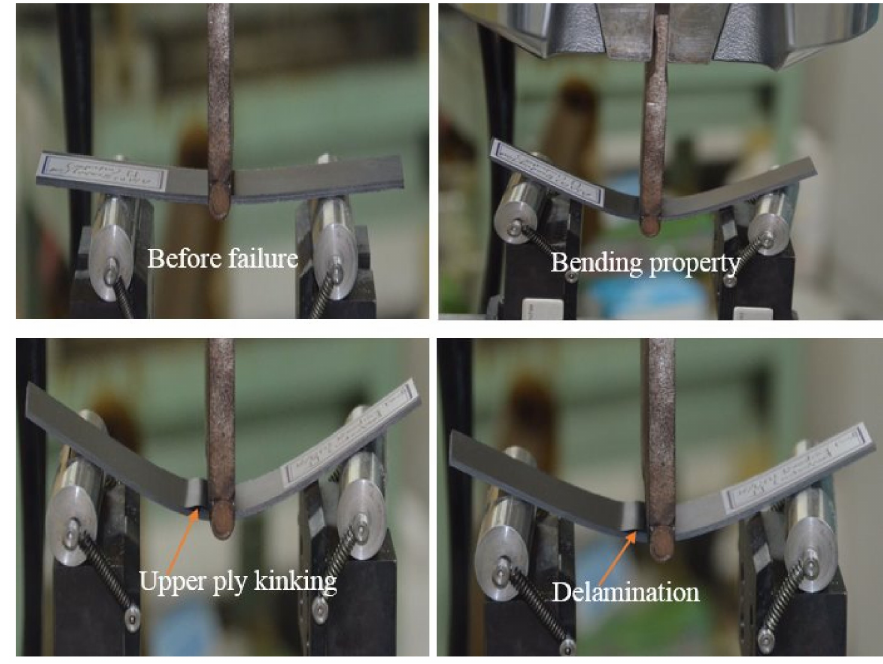
Figure 6. Visually inspect failure modes of the composite